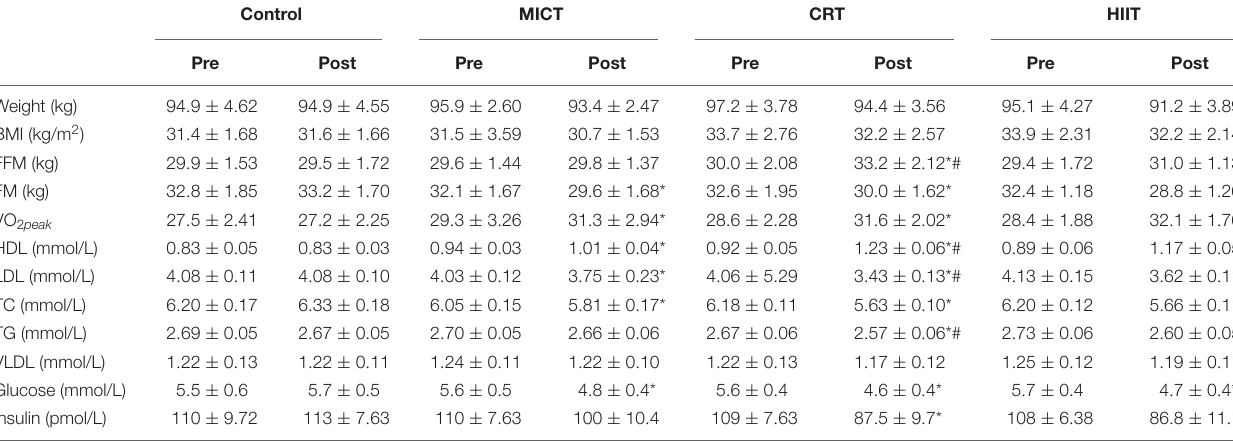
TABLE 3 | Pre and Post mean (sd, ± ) cardiometabolic and body composition variables by group.